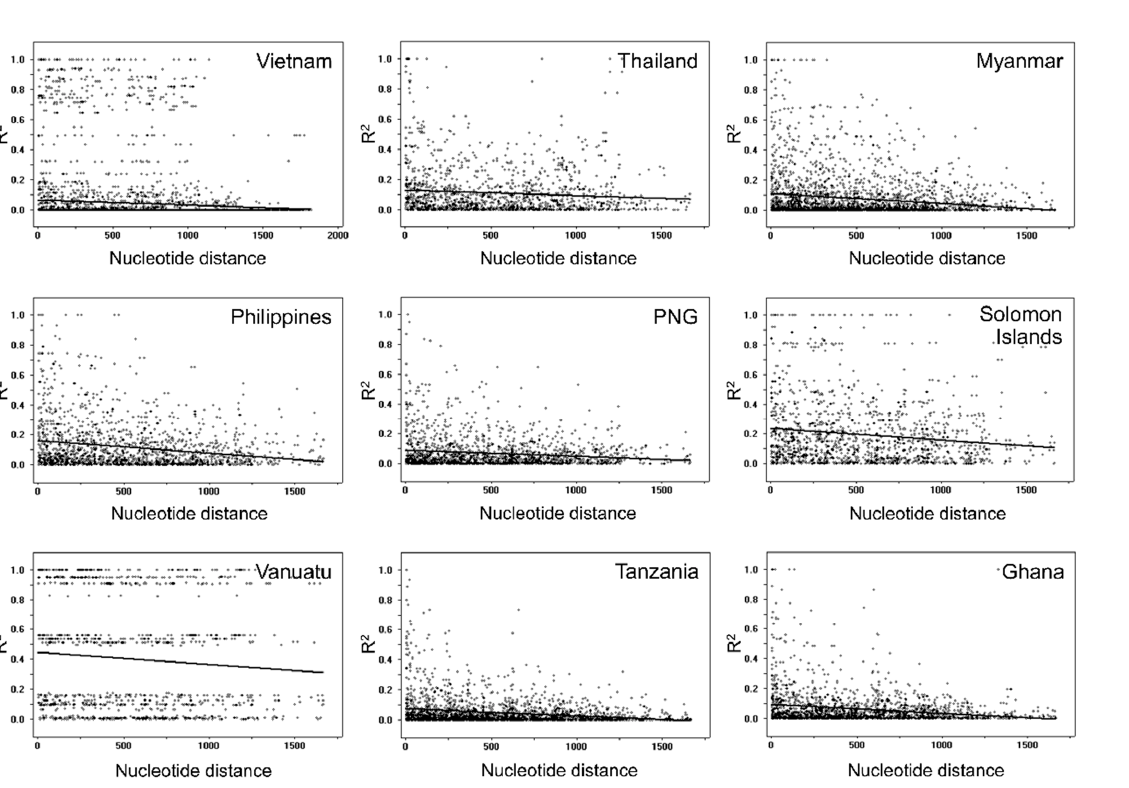
Figure 6. Recombination event in global pfama-1 . Linkage disequilibrium (LD) plot suggested non-random associations between nucleotide variations in pfama-1 at different polymorphic sites. R 2 values were plotted against nucleotide distance using a two-tailed Fisher’s exact test for statistical significance. PNG, Papua New Guinea. The global patterns except Vietnamese pfama-1 have been analyzed previously [25], and the previous data were applied to analyze overall patterns.